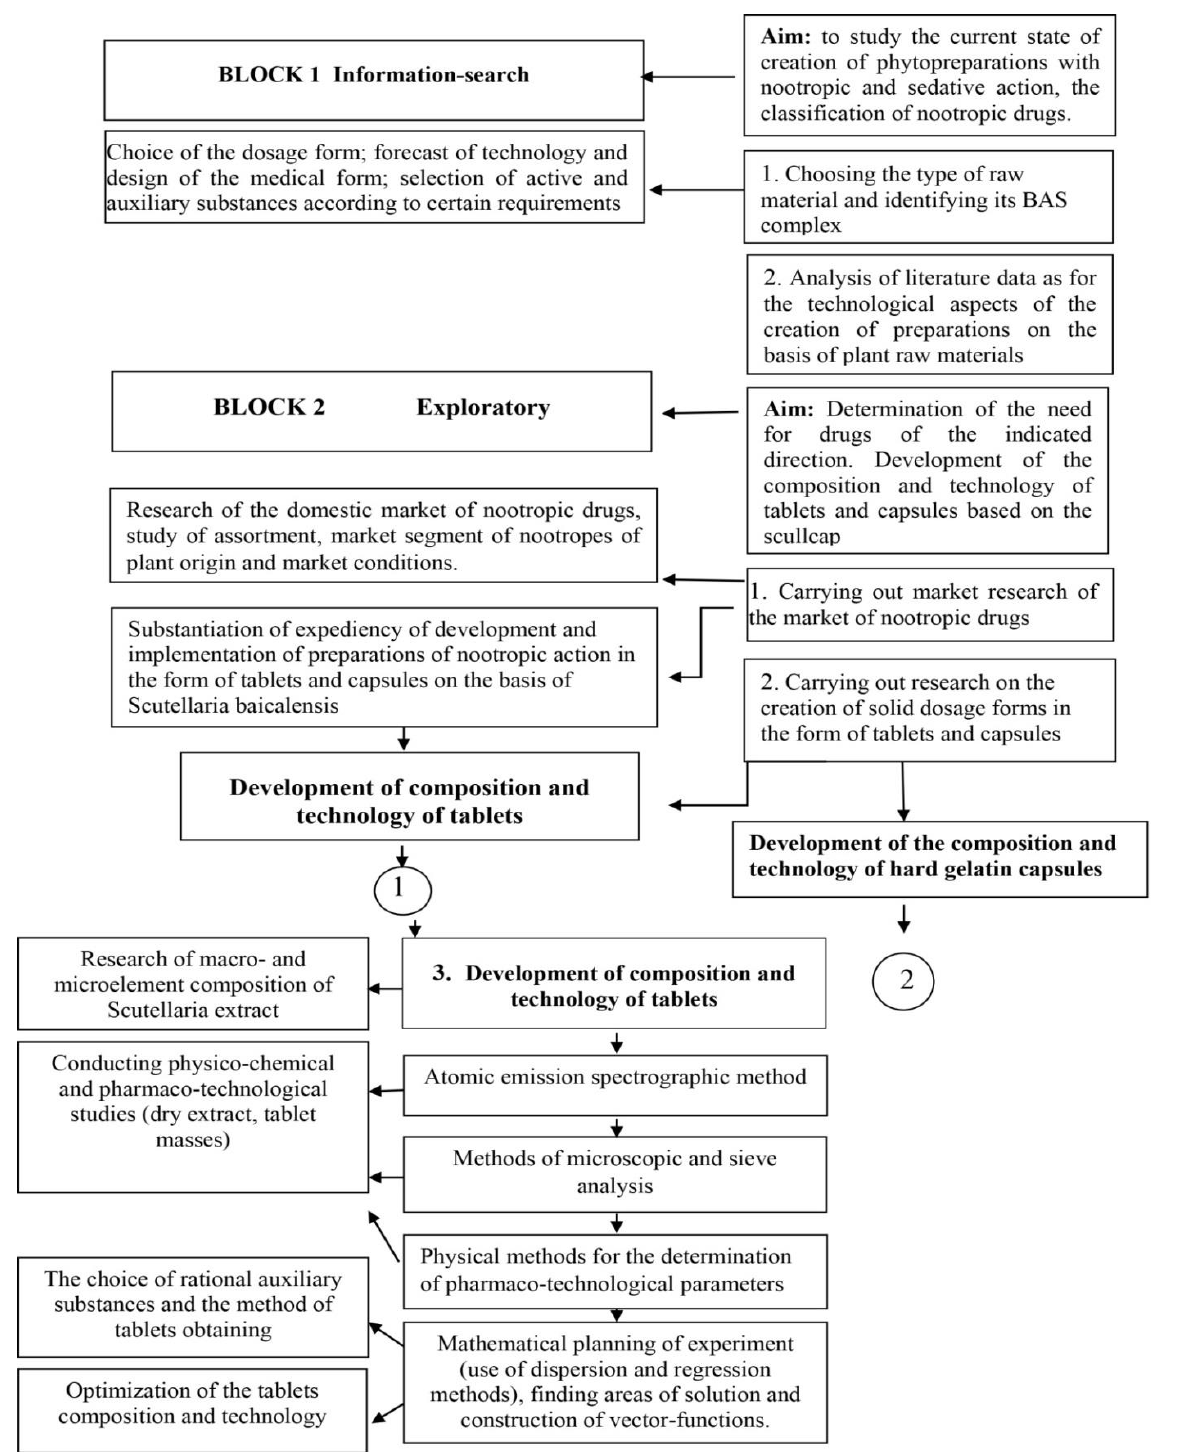
Fig. 1. Methodological approach to the creation of drugs with nootropic action on the basis of plant